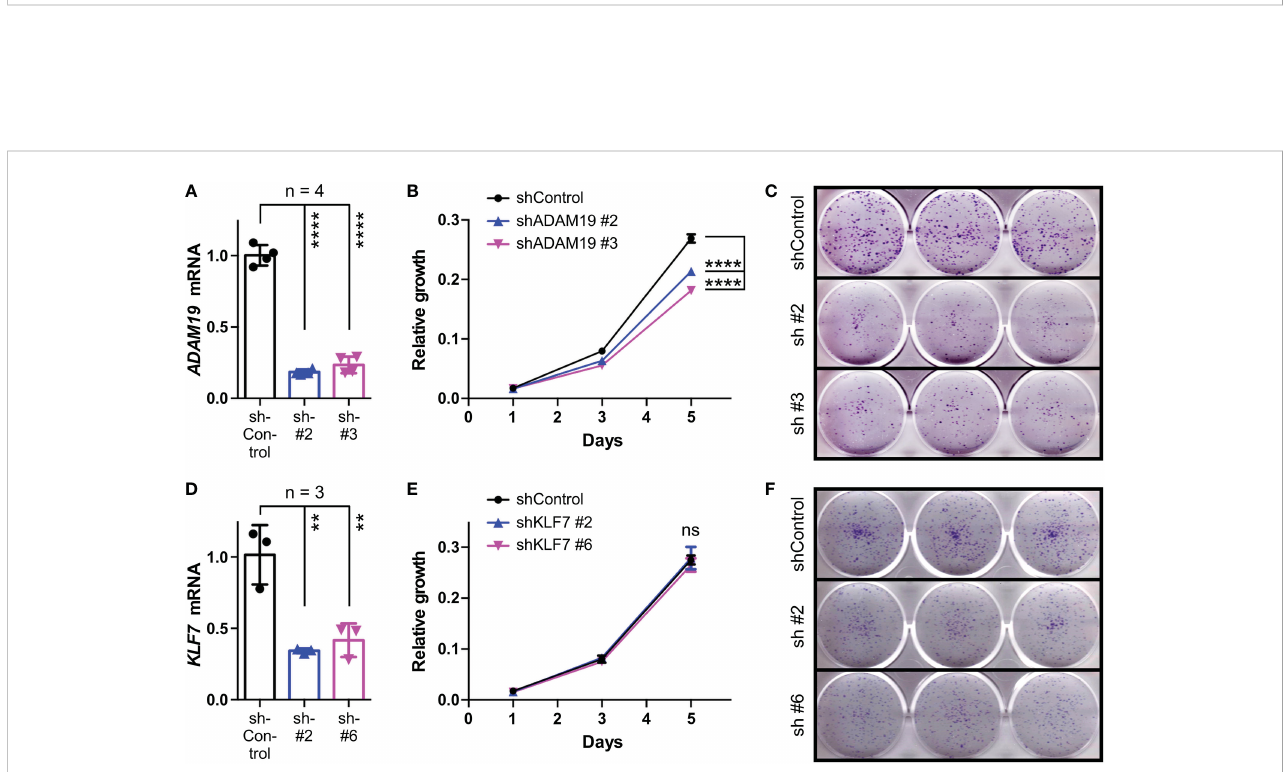
FIGURE 8 Role of KLF7 and ADAM19 for HCT116 cell growth and clonogenicity. (A) Downregulation of ADAM19 with two different shRNAs. Shown are ADAM19 mRNA levels normalized to GAPDH levels (means with standard deviations). One-way ANOVA with post hoc Tukey ’ s multiple comparisons test. (B) Impact of ADAM19 downregulation on cell growth. Shown are means with standard deviations (n=3). Two-way ANOVA with post hoc Tukey ’ s multiple comparisons test. (C) Clonogenic assays upon ADAM19 downregulation; shown are representative images. (D-F) Analogous to panels A-C for KLF7. **P < 0.01; ****P < 0.0001; ns, not signi fi